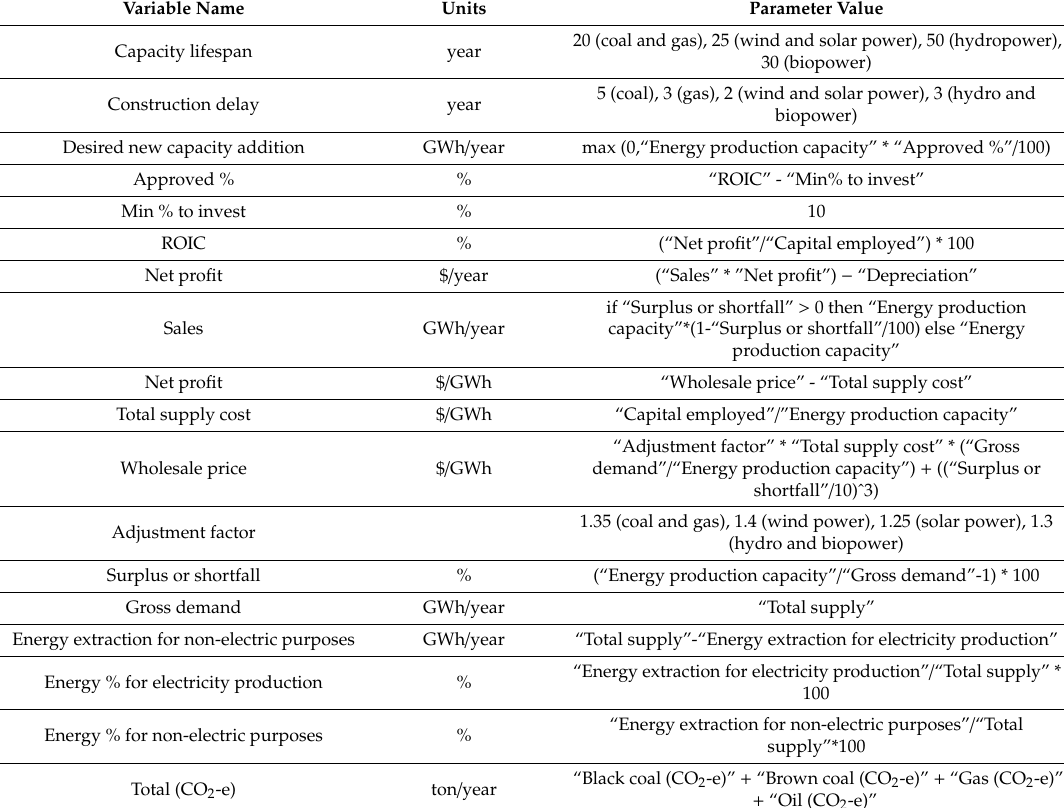
Table A3. Parameters used for auxiliary